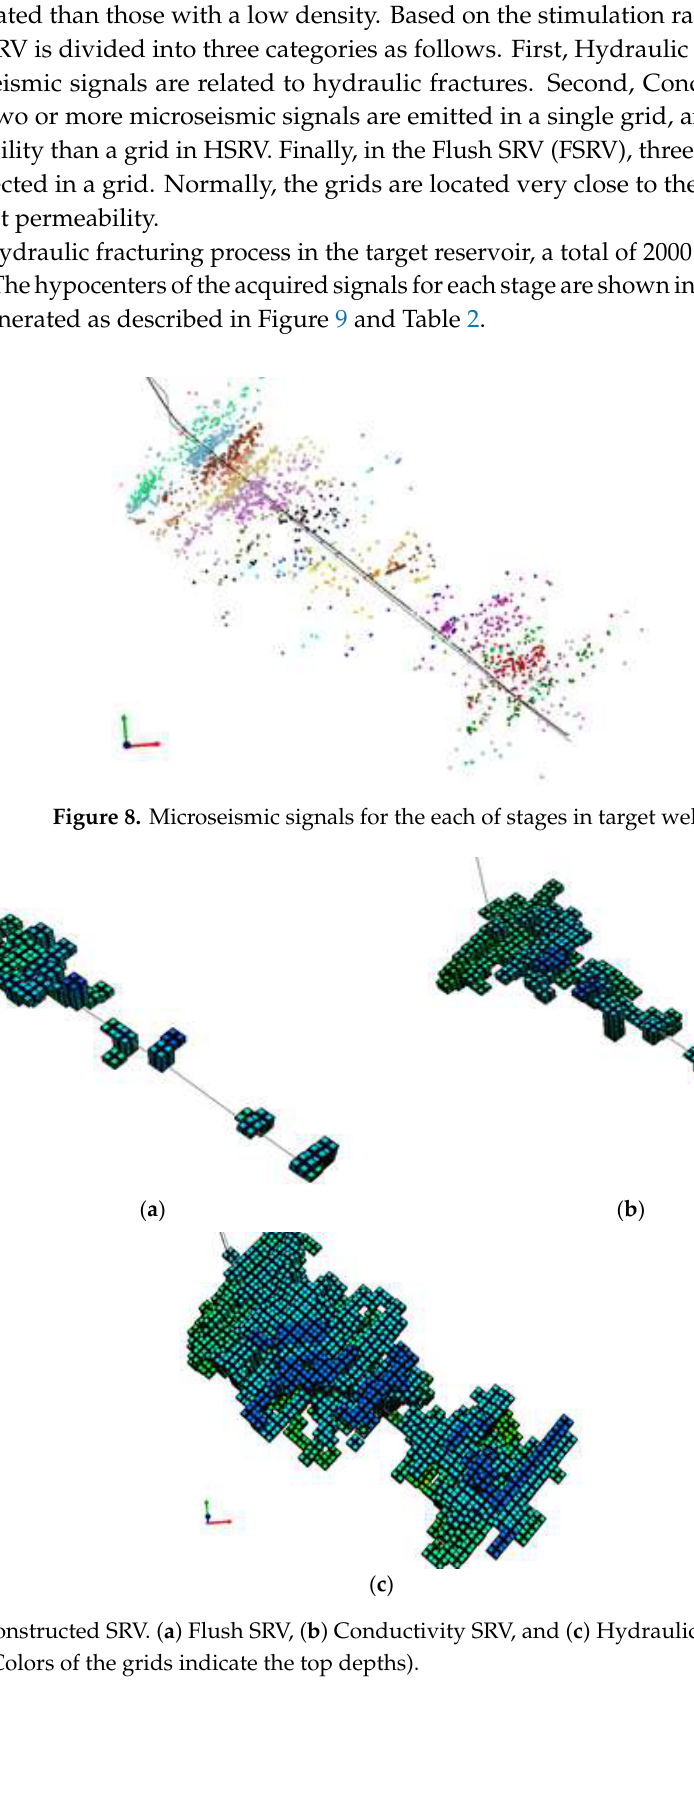
Table 2. Stimulated reservoir volume (SRV) information.